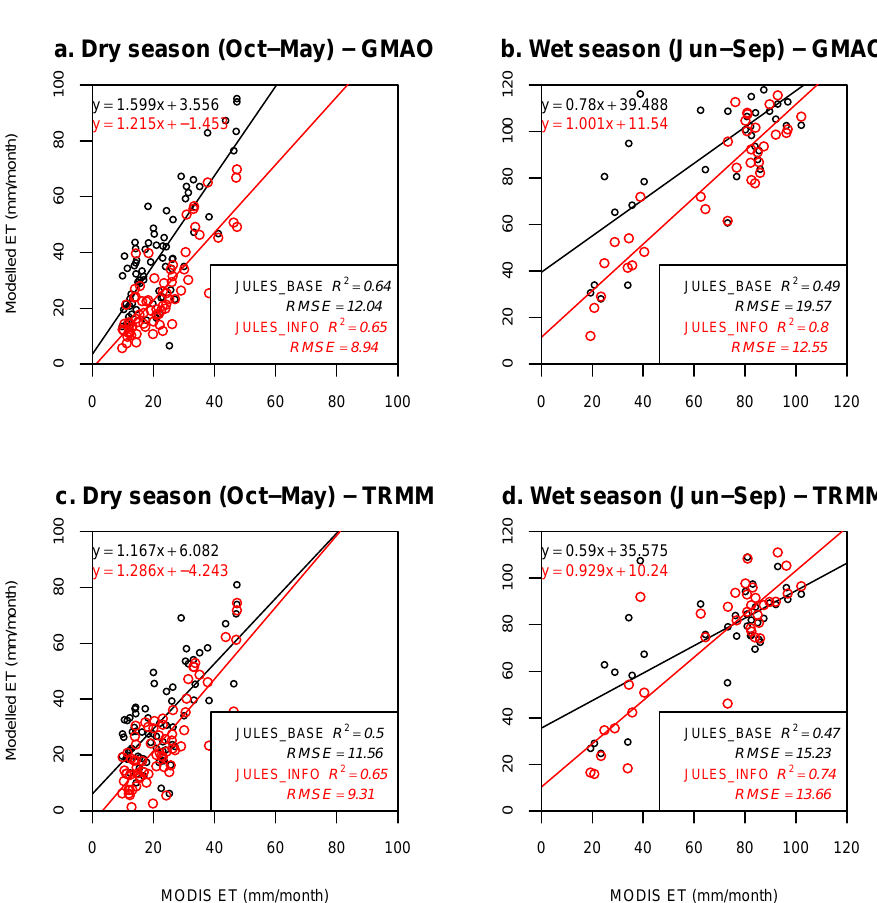
Figure 10. Results showing coefficient of determination ( R 2 ) and RMSE values are partitioned into wet (June–September) and dry (October– May) periods.